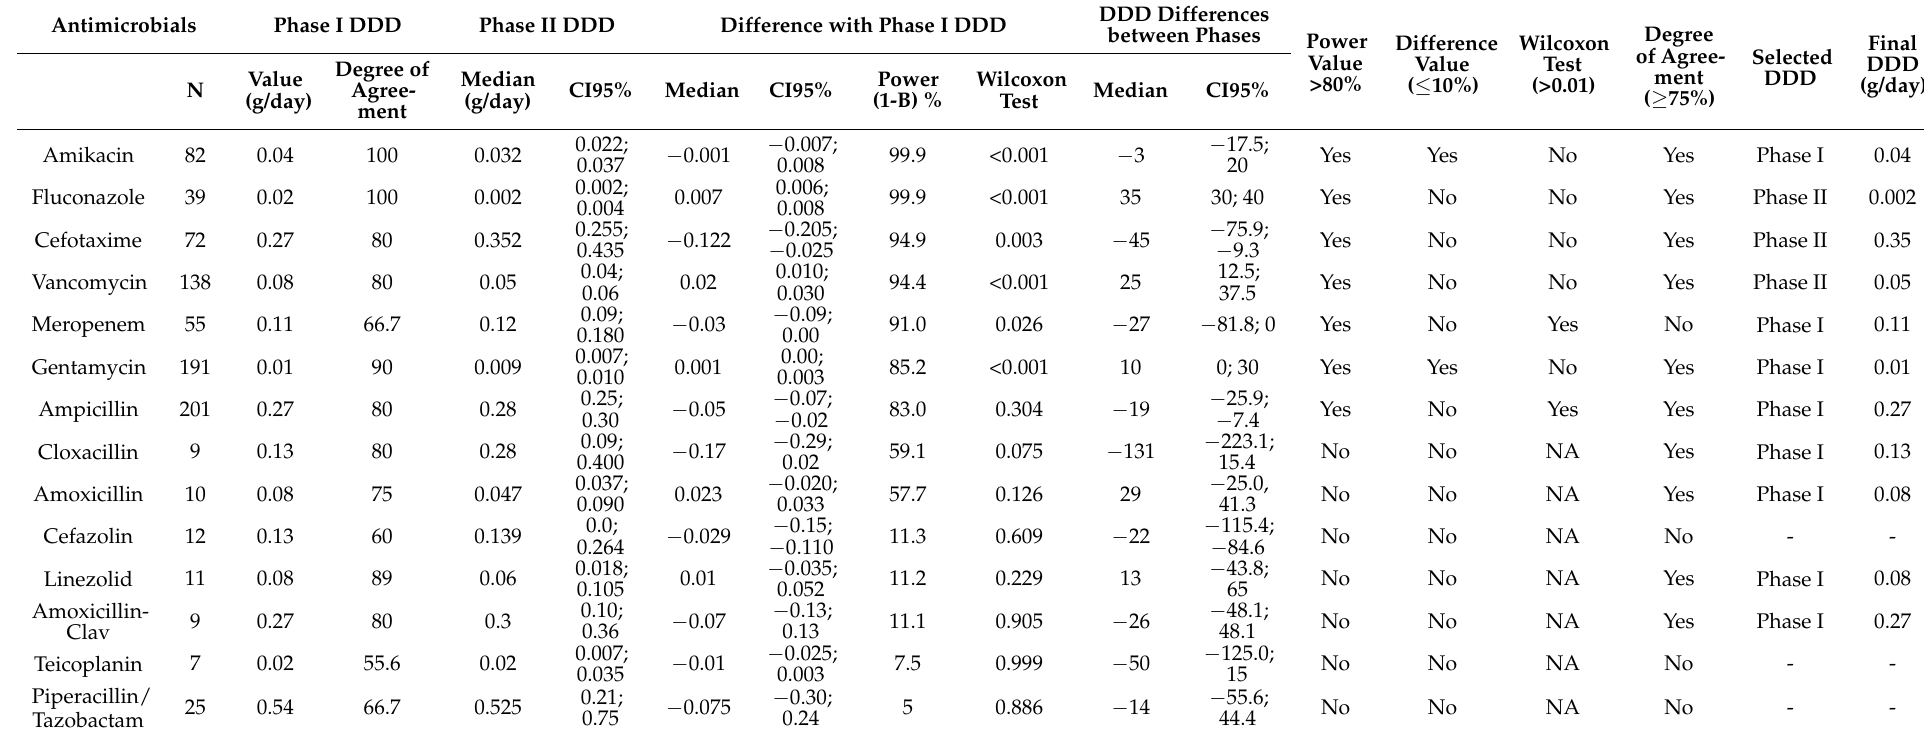
Table 4. Neonatal defined daily dose of antimicrobials according to the results of data